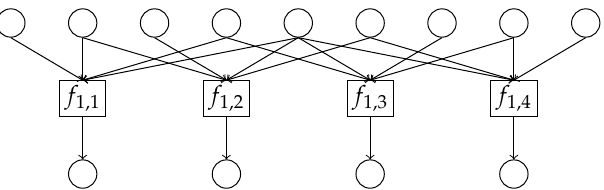
Figure 1. Pattern diagram of a stencil on 3 × 3 matrix with a 2 × 2